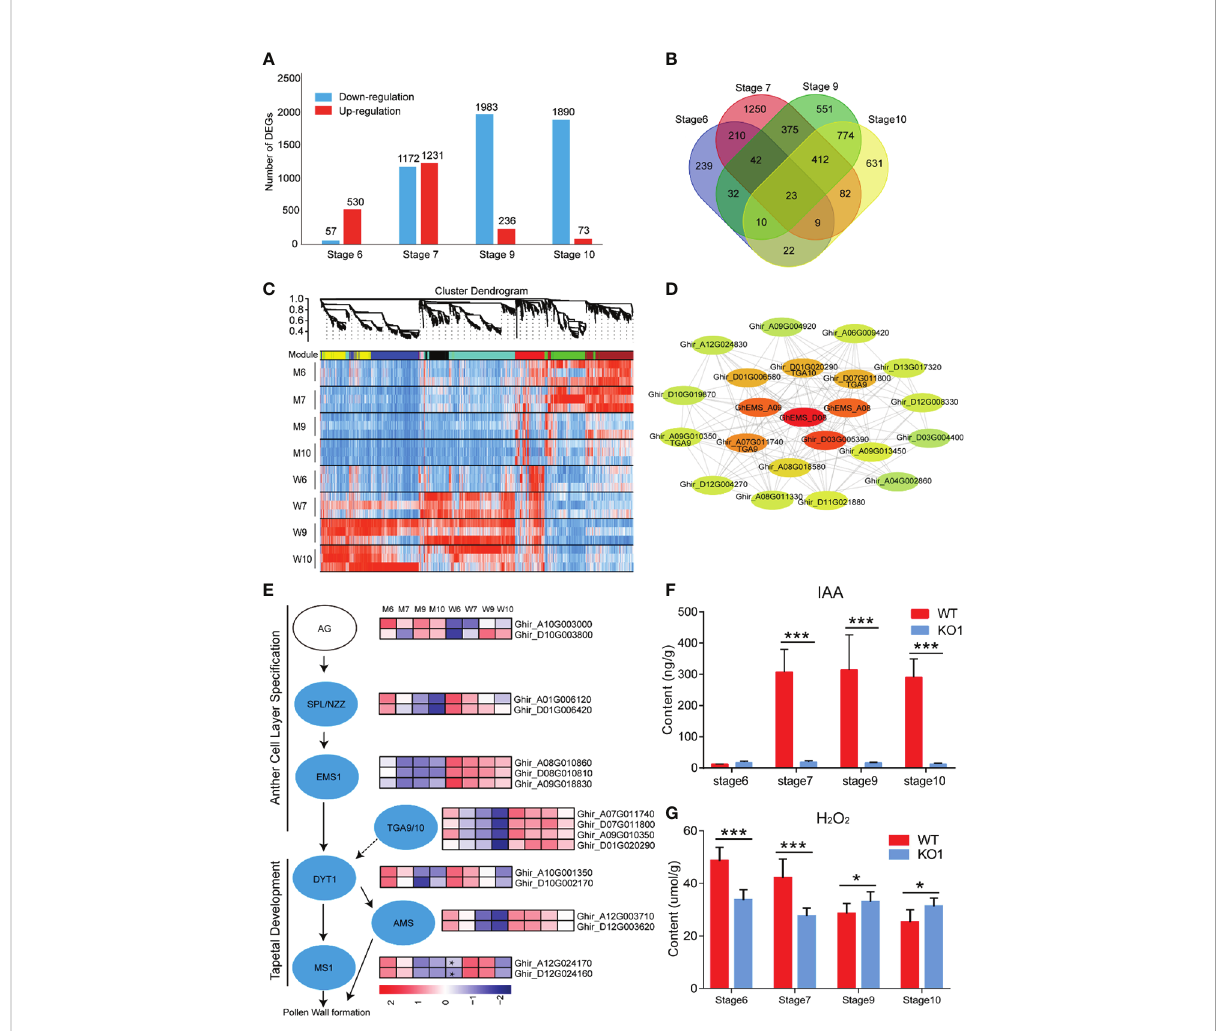
FIGURE 6 Transcriptome analysis of four developmental stages. (A) Difference gene statistics of wild type and mutant in four periods; (B) Intersection of differential genes at different stages; (C) WGCNA co-expression module, a total of 8 different modules; (D) Analysis of the co-expression network of the red module. The shades of color represent correlations; (E) Gene expression of the regulatory network of pollen development; AG , AGAMOUS ; (F) IAA content at four developmental stages; (G) H 2 O 2 content at four developmental stages. W, wild type; M, mutant; AMS , ABORTED MICROSPORE ; DYT1 , DYSFUNCTIONAL TAPETUM 1 ; EMS1 , EXCESS MICROSPOROCYTES 1 ; MS1 , MALE STERILITY 1 ; NZZ/ SPL , SPOROCYTELESS/NOZZLE . Data are presented as means ± SE from fi ve biologically independent experiments. Asterisks indicate statistically signi fi cant differences (***, P < 0.001; *, P < 0.05); by Student ’ s t